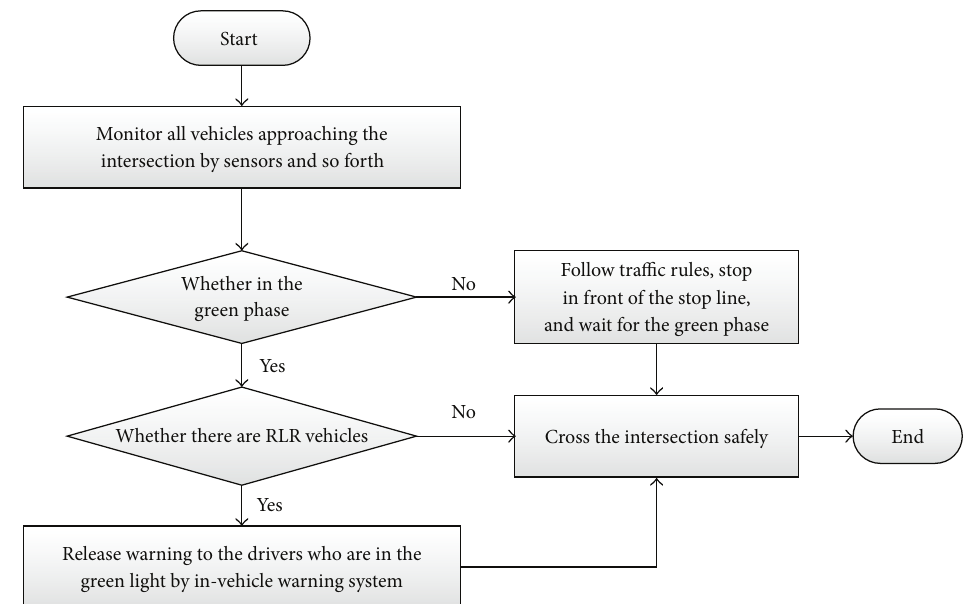
Figure 1: Flow chart of